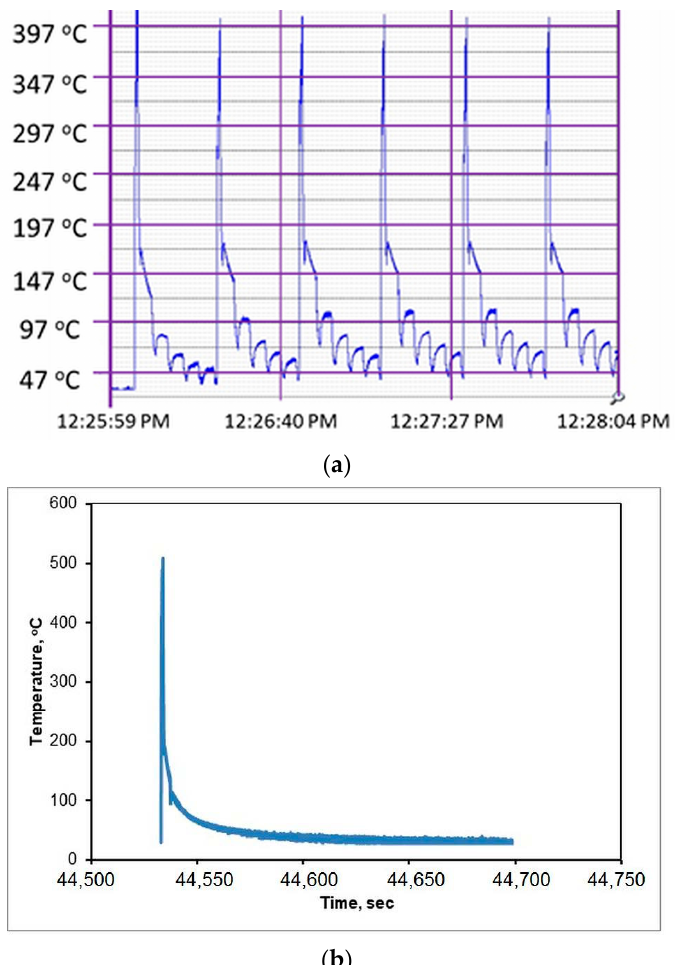
Figure 6. Pyrometer data of surface temperature measurements at the section AA: ( a ) the steady state process (LumaSense Technologies Co software); ( b ) appearance of the first temperature peak [14].